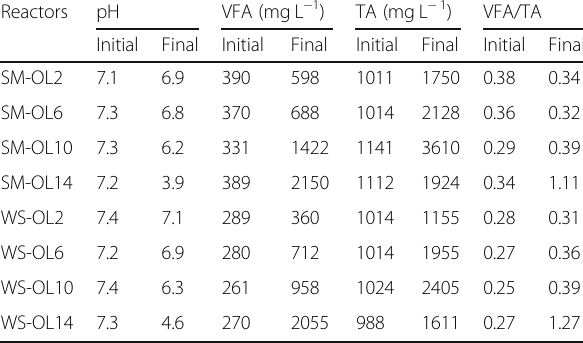
Table 1 Effect of OLs on stability parameters of